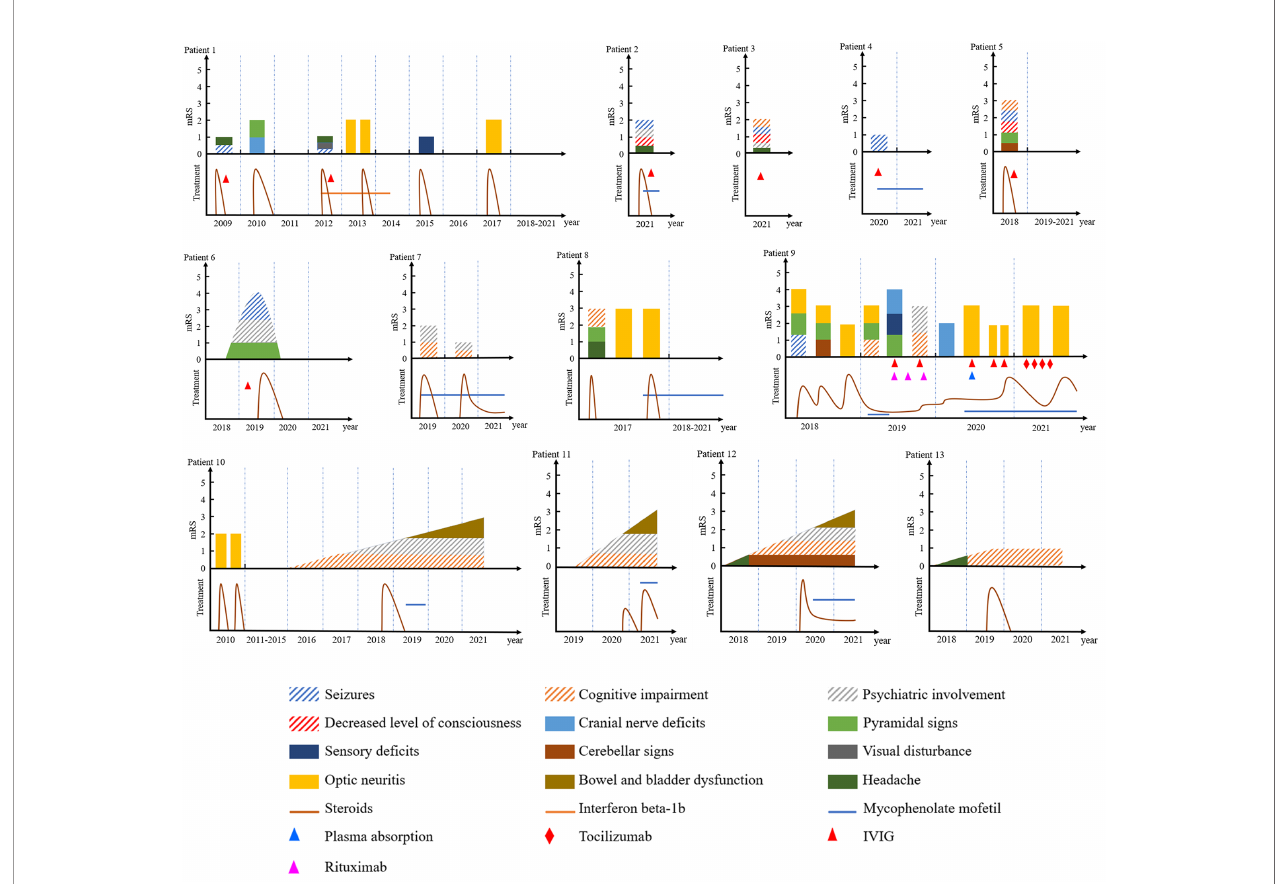
FIGURE 2 | Clinical courses and treatment in each MOG-E patient. Bars of encephalitic symptoms (seizures, cognitive impairment, psychiatric symptoms, and/or decreased level of consciousness) are shadowed. IVIG, intravenous immunoglobulin; mRS, modi fi ed Rankin